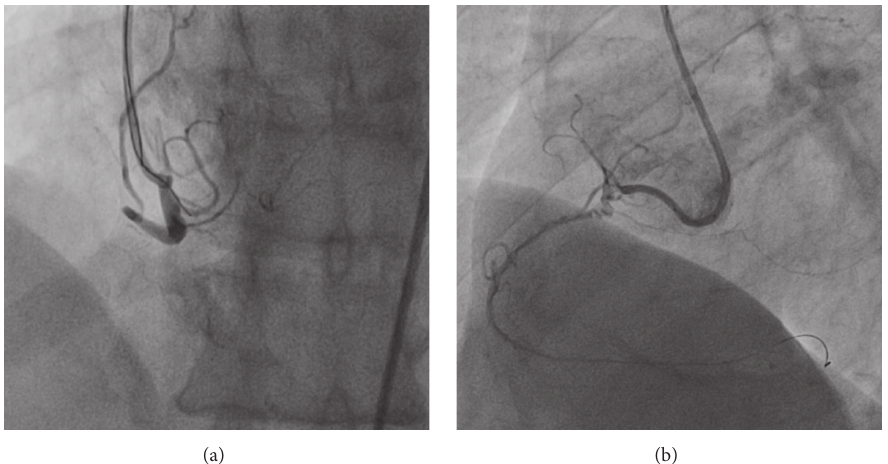
Figure 2: Coronary angiogram of the right coronary artery, in two projections, before (a) and after insertion of the guide-wire